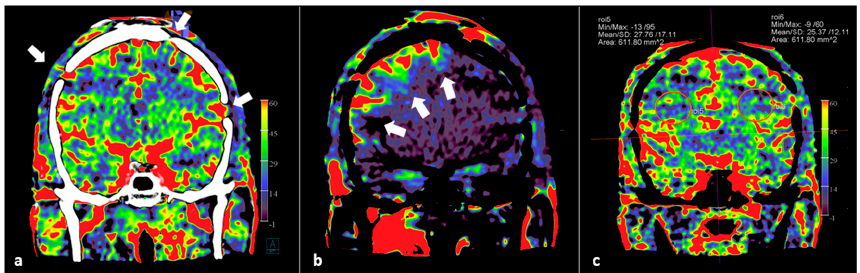
Figure 4. Selective and whole brain FD CT PBV imaging in a 29-year-old Asian male with moyamoya disease, treated by multiple burr holes surgery. Scanning was performed during aortic root injection (whole brain PBV imaging) and during selective ECA injection. ( a ) Coronal mask and PBV fusion MIP reformation demonstrates symmetrical PBV maps, and shows that multiple burr holes are present (white arrows). ( b ) Coronal PBV MIP reformation with selective right ECA contrast injection displays the blood supply to the right cerebral hemisphere (white arrows). ( c ) PBV value measurements in symmetrically plotted ellipsoid regions of interest (ROI) show symmetric PBV values. In summary, FD CT PBV imaging by means of selective single artery contrast injection and whole brain contrast injection allows the evaluation of the impact of revascularization procedures in patients with chronic steno-occlusive disease both during the procedure and in long-term follow-up.